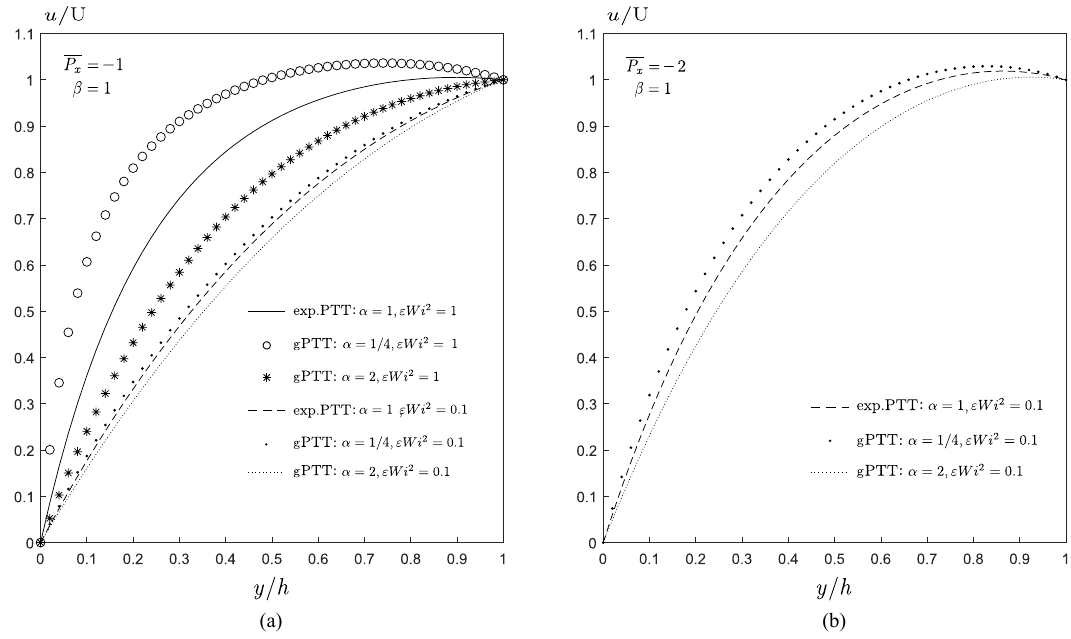
Figure 5. Velocity profiles obtained for the Poiseuille–Couette flow considering different values of ε Wi 2 and different values of α ( β = 1): ( a ) ¯ P x = − 1; and ( b ) ¯ P x = −